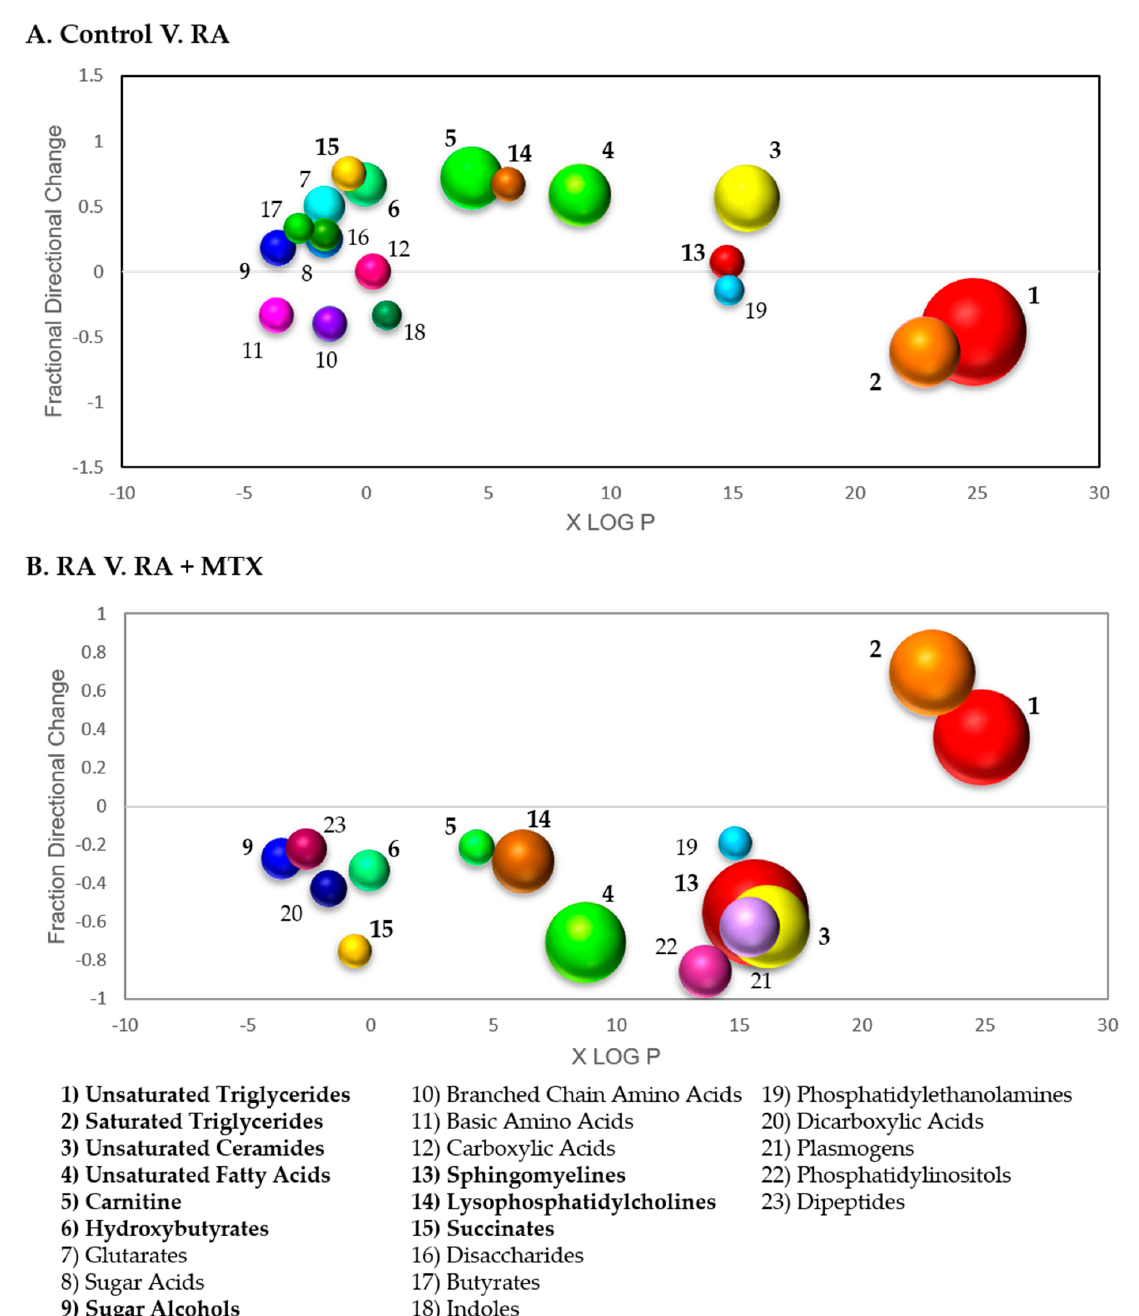
Figure 4. Chemometric enrichment analysis of metabolomic profiling data: ( A ) Metabolomic data comparing RA patients at baseline to healthy control subjects was analyzed using ChemRICH open-source software to produce nonoverlapping chemical cluster classifications mapping 551 of the total 647 metabolites to 57 nonoverlapping chemical clusters. Among these clusters differentiating healthy control subjects and RA patients, 19 clusters were found to be statistically significant using an FDR-adjusted p -value cutoff of 0.05; ( B ) metabolomic data from RA patients at baseline and following 16 weeks of MTX therapy was analyzed and 551 of the total 647 metabolites mapped to 56 nonoverlapping chemical clusters. Among these clusters differentiating baseline disease state and sixteen weeks post MTX therapy, 19 clusters were found to be statistically significant. Each cluster of metabolites was plotted based on lipophilicity, fraction directional change, and p -value; node size is directly proportional to the negative logarithm of the p -value for each cluster. Bolded clusters of metabolites were found to display a correction towards levels observed in healthy control subjects following the initiation of MTX in RA